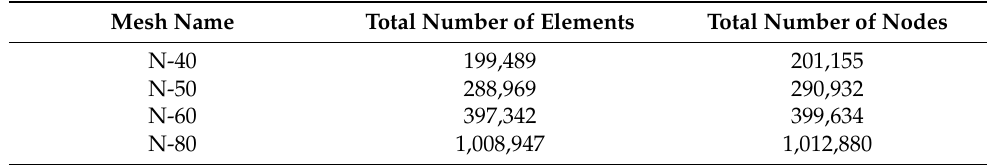
Figure 7. Local error analysis of the mean velocity along the centerline based on the finest (N-80) mesh. The mean velocity is normalized by the inlet mean velocity V in = 44.83 m/s. Table 1. Mesh details for